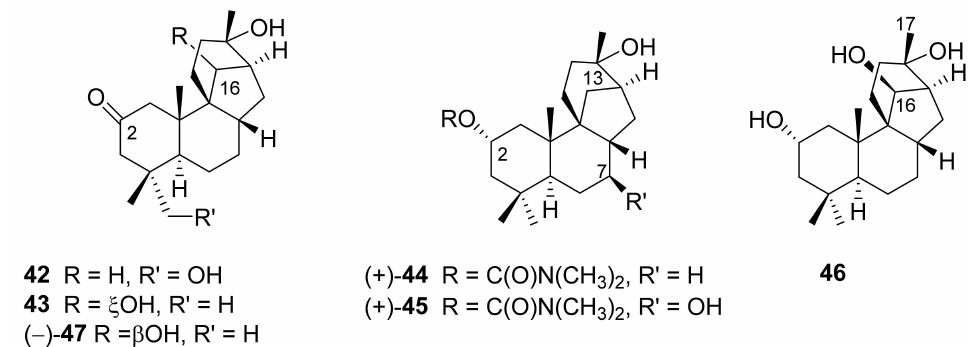
Figure 10. Stemodane diterpenoids biotransformation metabolites.